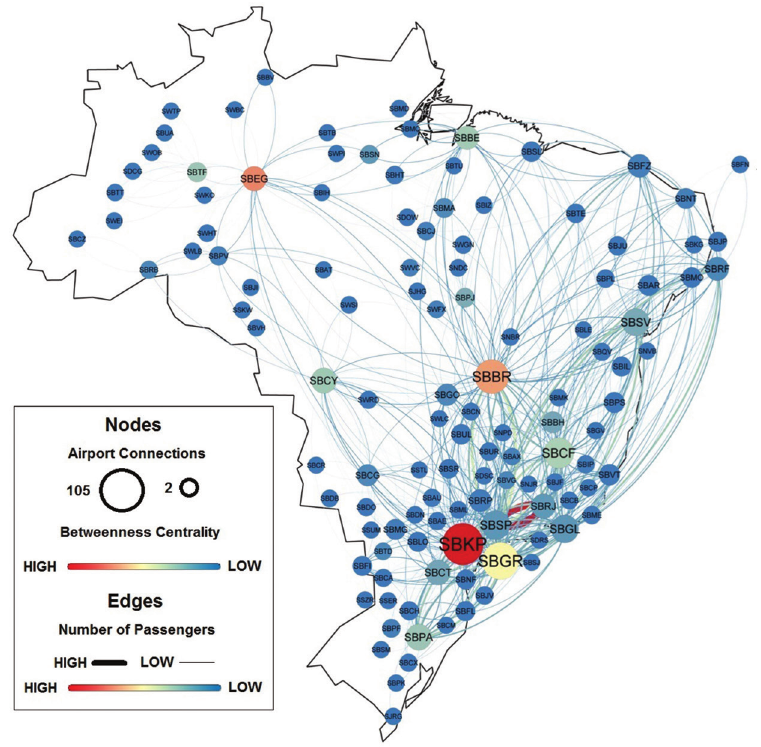
Figure 1 - Central Brazilian Airports - National Flights. For interpretation of the references to color in this figure, the reader is referred to the web version of this